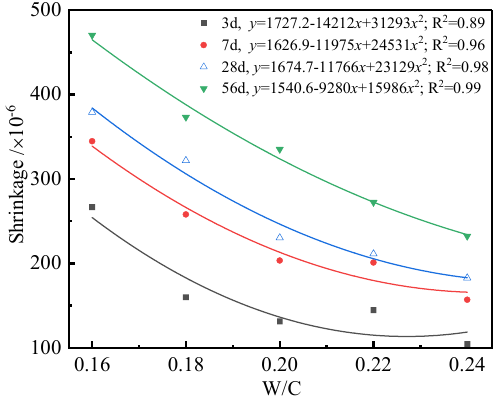
Figure 3. The shrinkage curves of the UHPC with curing ages.